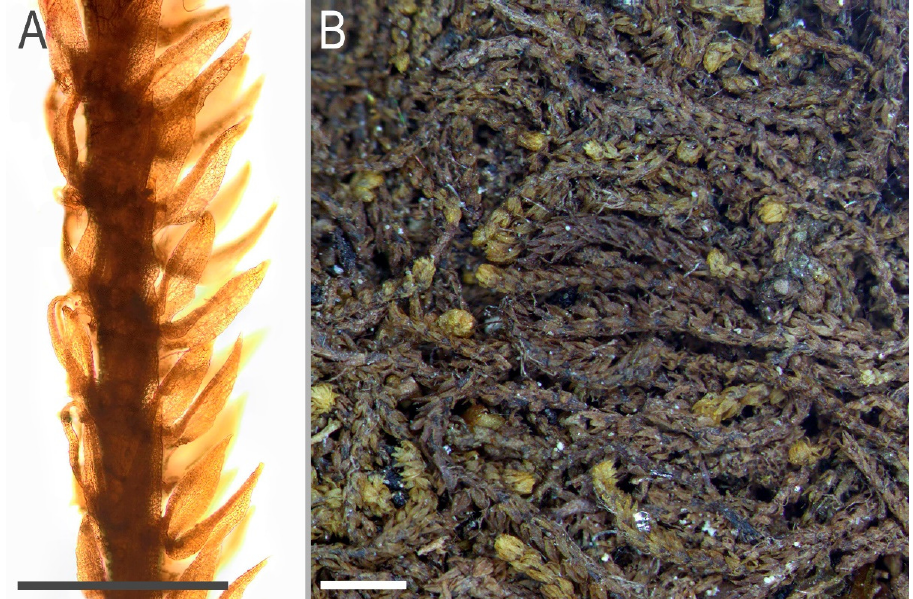
Figure 13. Tetralophozia pusilla (Steph.) Bakalin et Vilnet: A —plant habit. fragment. lateral view; B — mat. dorsal view. Scales: A —500 µm. B —2 mm. All from G00283395.